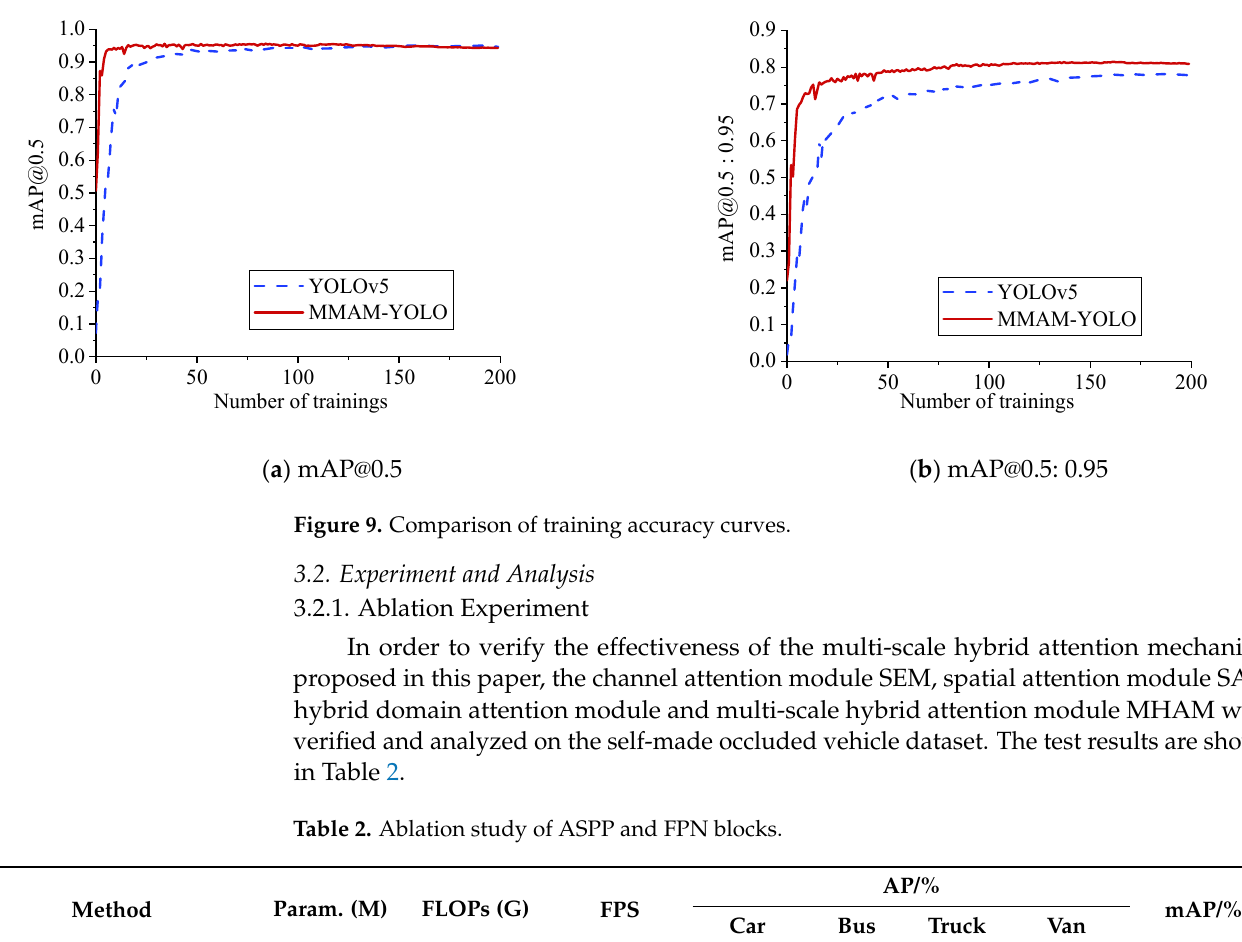
9 of 15 Figure 8. Total loss convergence curve.